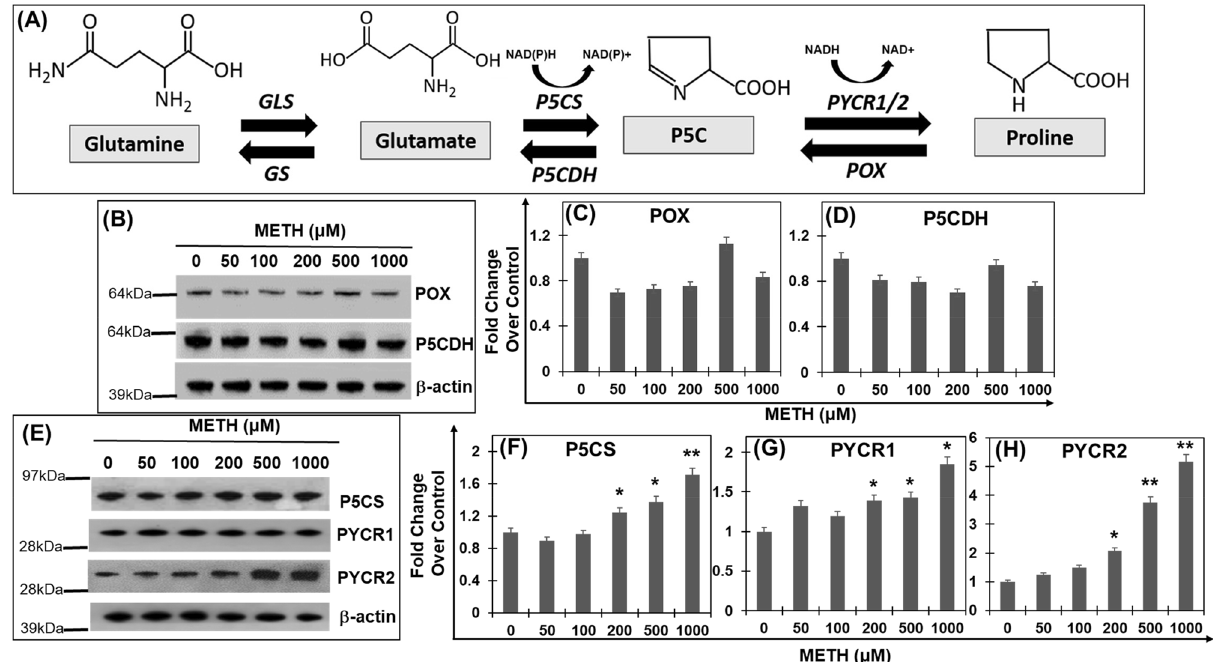
Figure 1. Acute METH exposure upregulates enzymes of proline synthetic pathway from glutamate. ( A ) Schematic depicting the metabolic link between glutamate and proline. Synthesis of proline begins with the conversion of glutamine to glutamate by the enzyme glutaminase (GLS). Glutamate is then converted by P5C synthase (P5CS) to glutamic-γ-semialdehyde that spontaneously cycles to Δ 1 -pyrroline-5-carboxylate (P5C). P5C is subsequently catalyzed to l-proline by P5C-reductase (PYCR). Conversely, catabolism of proline to glutamate is catalyzed in two consecutive steps by proline oxidase (POX) and P5C dehydrogenase (P5CDH). Glutamate is finally converted to glutamine by glutamine synthase (GS). ( B – D ) Effect of acute METH treatment on proline catabolic enzymes. SH-SY5Y cells were treated with increasing concentrations of METH for 24 h. Post-treatment cells were harvested and lysed. Cell lysates were subjected to immunoblot analyses. ( B ) Representative immunoblot of enzymes involved in catabolism of proline to glutamate (n = 3) (Fig. S1). ( C , D ) Densitometry analysis of POX and P5CDH, respectively normalized to β-actin. ( E – H ) Effect of acute METH treatment on proline metabolic enzymes. ( E ) Representative immunoblot of enzymes, P5CS, PYCR1 and PYCR2, which are essential for proline biosynthesis from glutamate (n = 3). ( F – H ) Densitometry analysis of P5CS, PYCR1, and PYCR2, respectively normalized to β-actin. Data presented in panels ( C , D , F – H ) are mean values of three independent experiments with error bars representing SEM. *p < 0.05, **p < 0.005 represent statistical comparison of untreated vs METH-treated